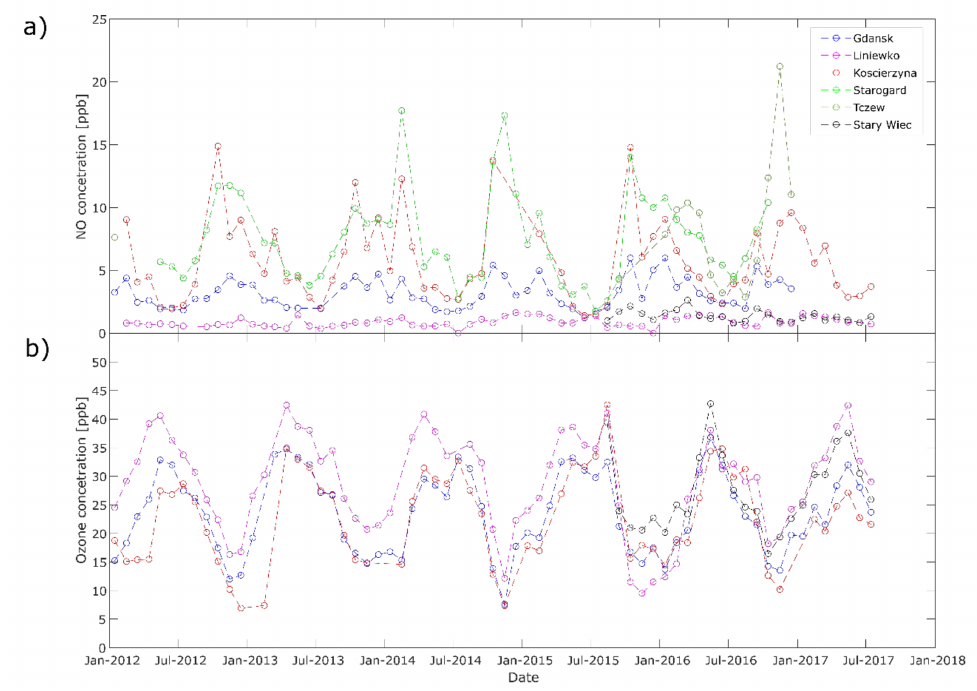
Figure 2. Monthly means of nitrogen oxide ( a ) and surface O 3 ( b ) concentrations at Stary Wiec and the surrounding stations for the period